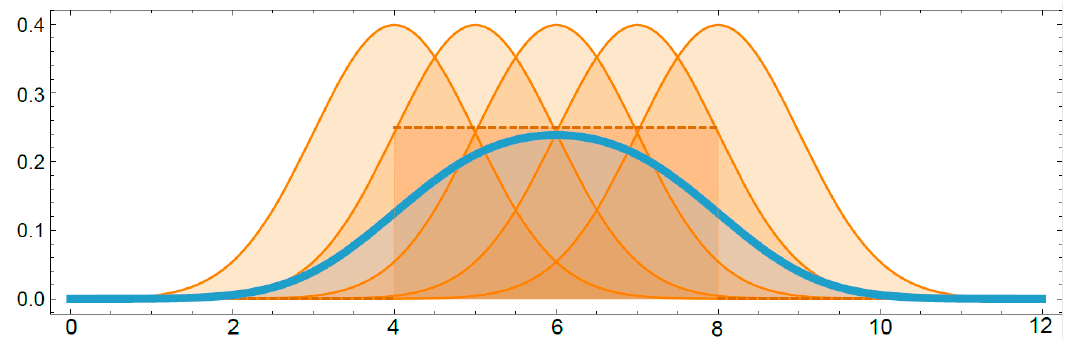
Figure 2. An example of a normal N ( θ ,1) model with a uniform U (4,8) prior distribution of θ .